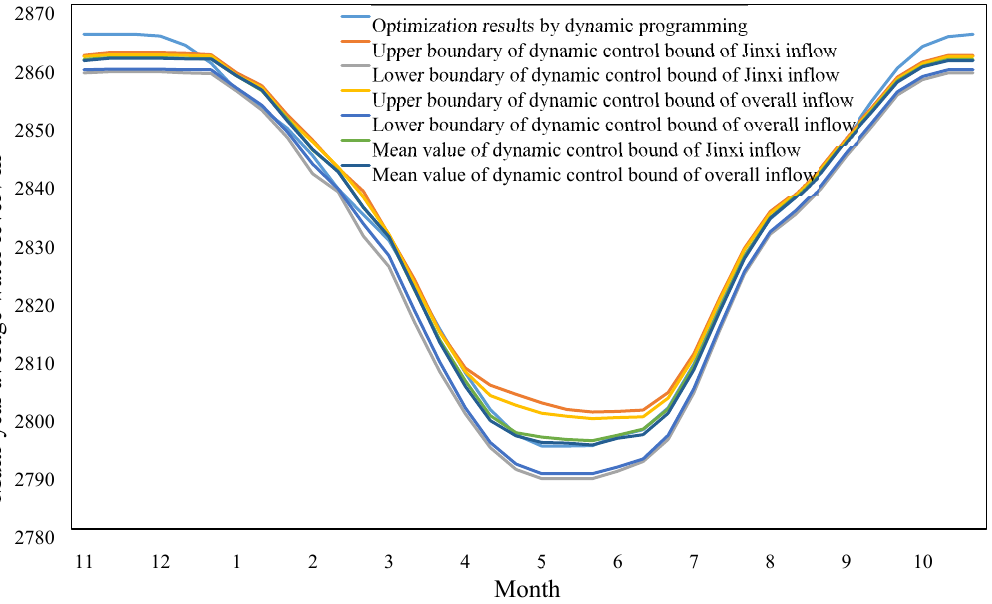
Figure 10. Overyear average water level processes of Lianghekou reservoir under different control rules.